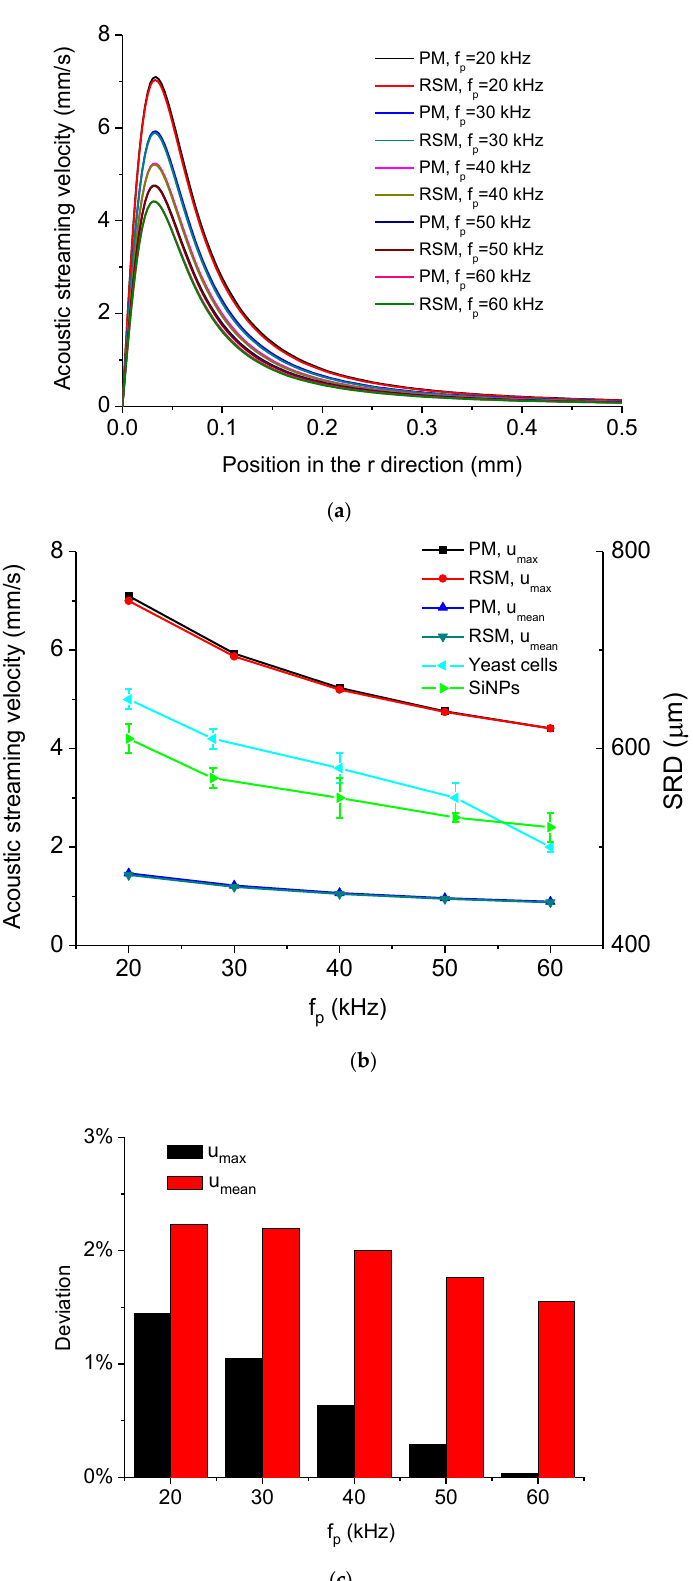
Figure 6. ( a ) Computed acoustic streaming velocity distribution along the r direction at the droplet-substrate interface in the ultrasonic probe-droplet-substrate system under different f p . ( b ) u max , u mean and SRD versus f p in the ultrasonic probe-droplet-substrate system. ( c ) Deviations of u max and u mean computed by the PM and RSM versus f p in the ultrasonic probe-droplet-substrate system. The dependency of acoustic streaming velocity on the distance between the MMP’s tip and substrate surface H is shown in Figure 7. Figure 7a shows the distribution of acoustic streaming velocity along the r direction at the droplet-substrate interface computed by the PM and RSM under different H , from which it is seen that the position where u max occurs moves outwards from point o when H increases. Figure 7b shows u max , u mean and experimentally measured SRD of the cleaned area for yeast cells and SiNPs versus H , from which it is seen that both u max and u mean decrease with the increase of H , which accounts for that the SRD decreases with the increase of H . In this case, one can realize the pinpoint or relatively large-area removal of micro/nanoscale particles just by tuning the distance between the MMP’s tip and substrate surface through controlling the X-Y-Z moving stage.